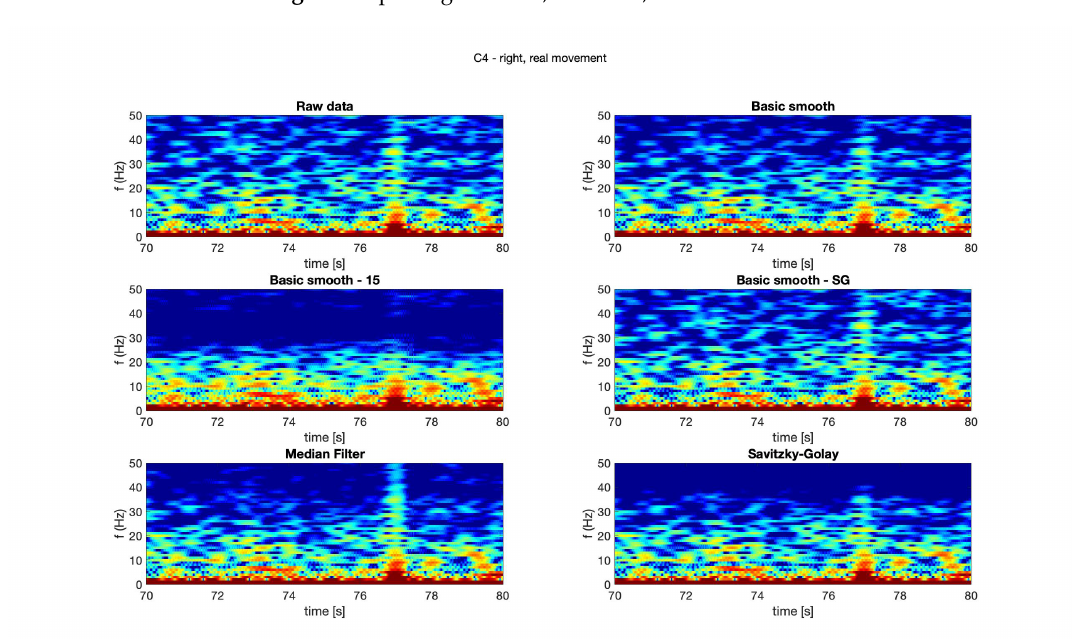
Figure 6. Spectrogram—C4, right hand, real